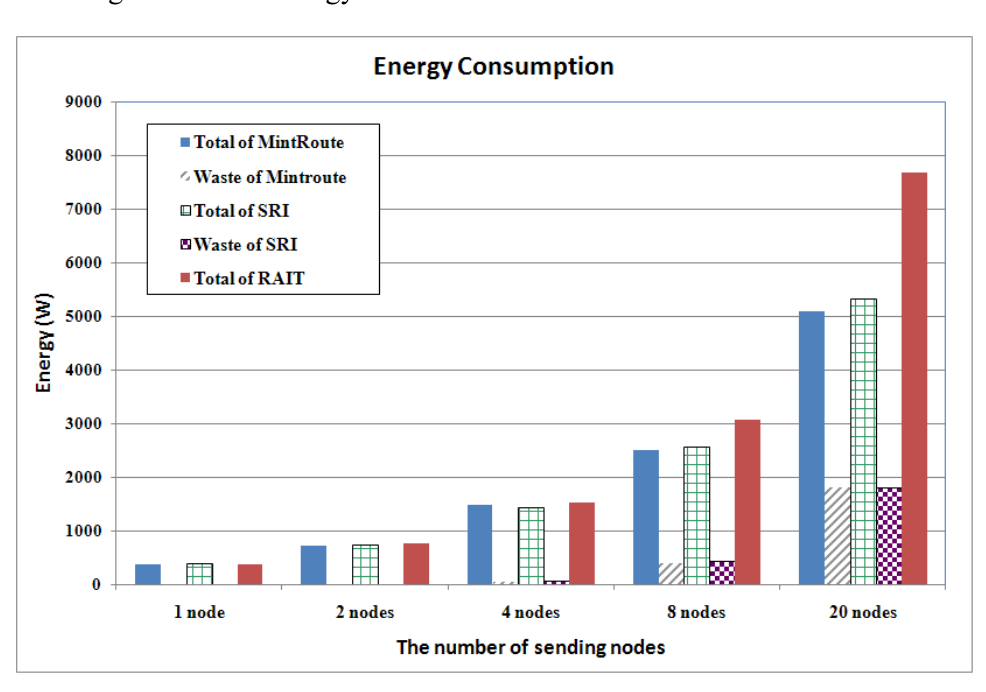
Figure 13. Energy Consumption. RAIT consumed more energy than SRI and MintRoute, however a large amount of energy was wasted with SRI and